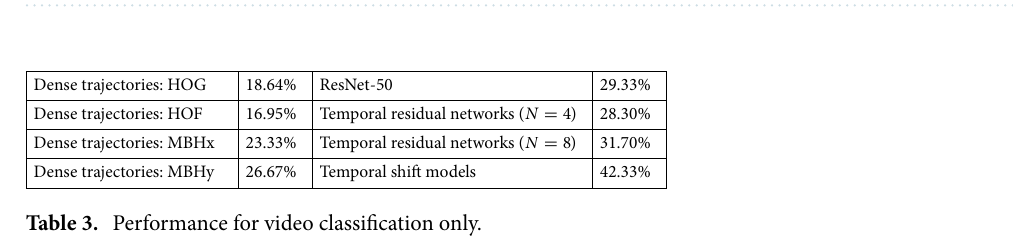
Table 2. Performance of learnable features for EEG classification.